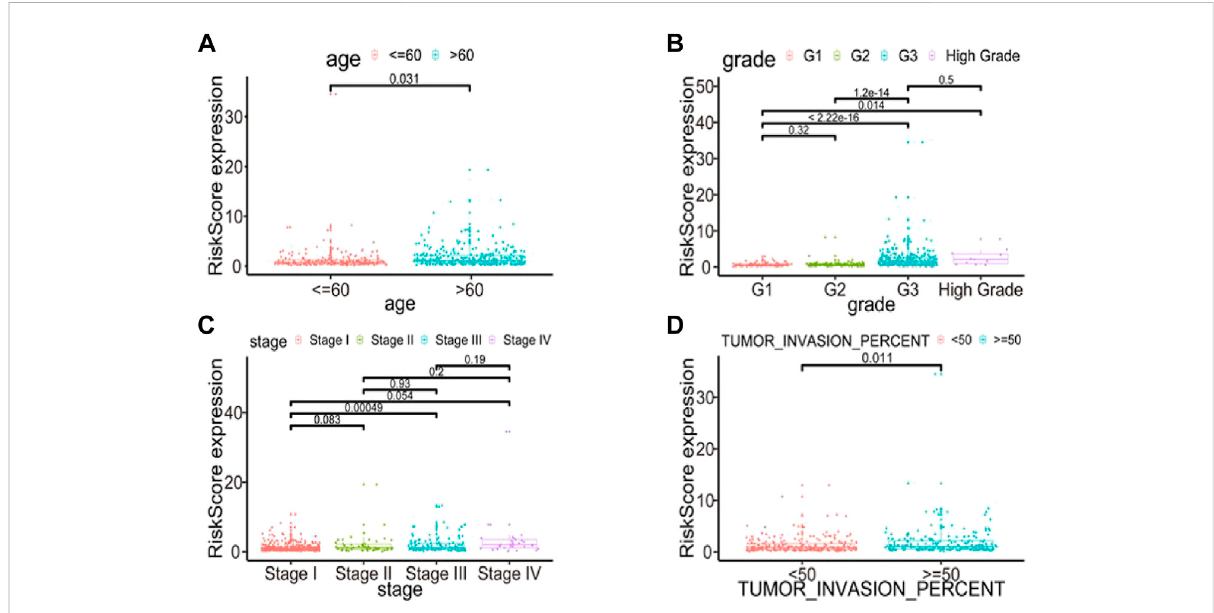
FIGURE 10 Relationships betweenriskscore and various clinical parameters.Riskscores incohorts strati fi edby age (A) , grade (B) , stage (C) , tumor invasion percent (D) . Risk score is signi fi cantly associated with age, grade and tumor invasion percent, but not completely with